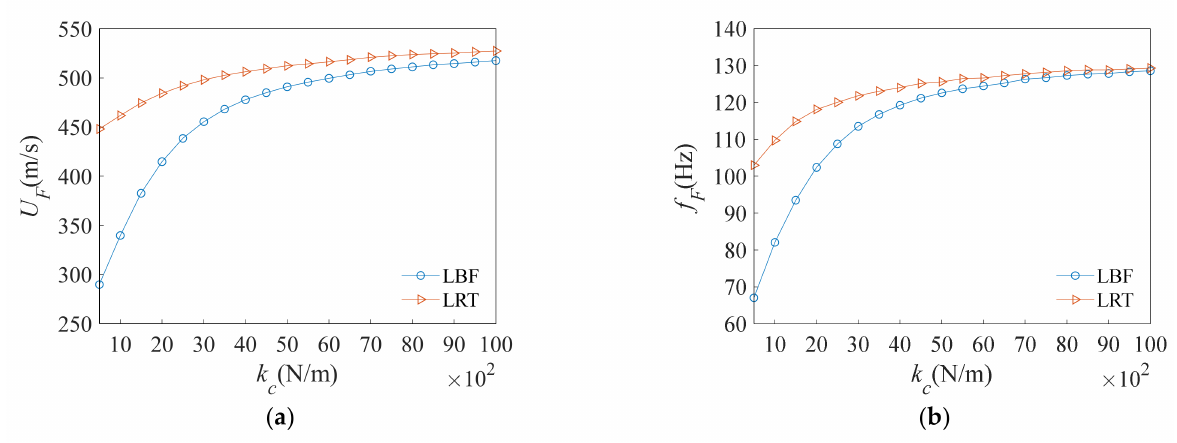
Figure 10. Flutter speeds and frequencies versus the stiffness of elastic supports: ( a ) U F versus k c ; ( b ) f F versus k c